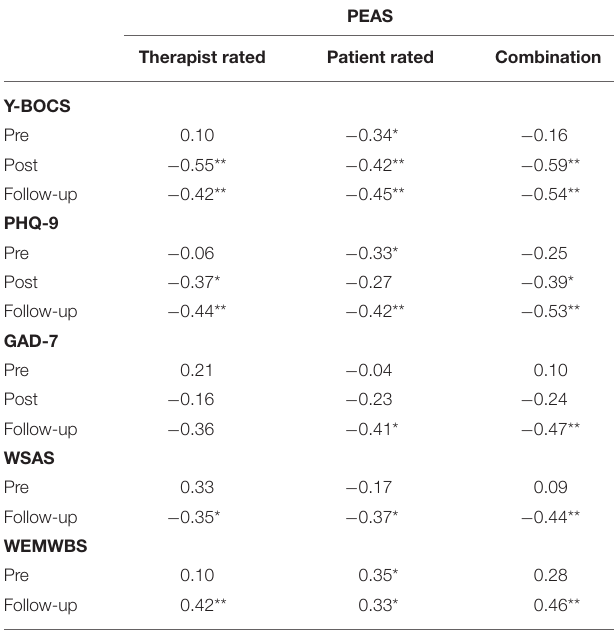
TABLE 2 | Relationship between treatment adherence and treatment outcome